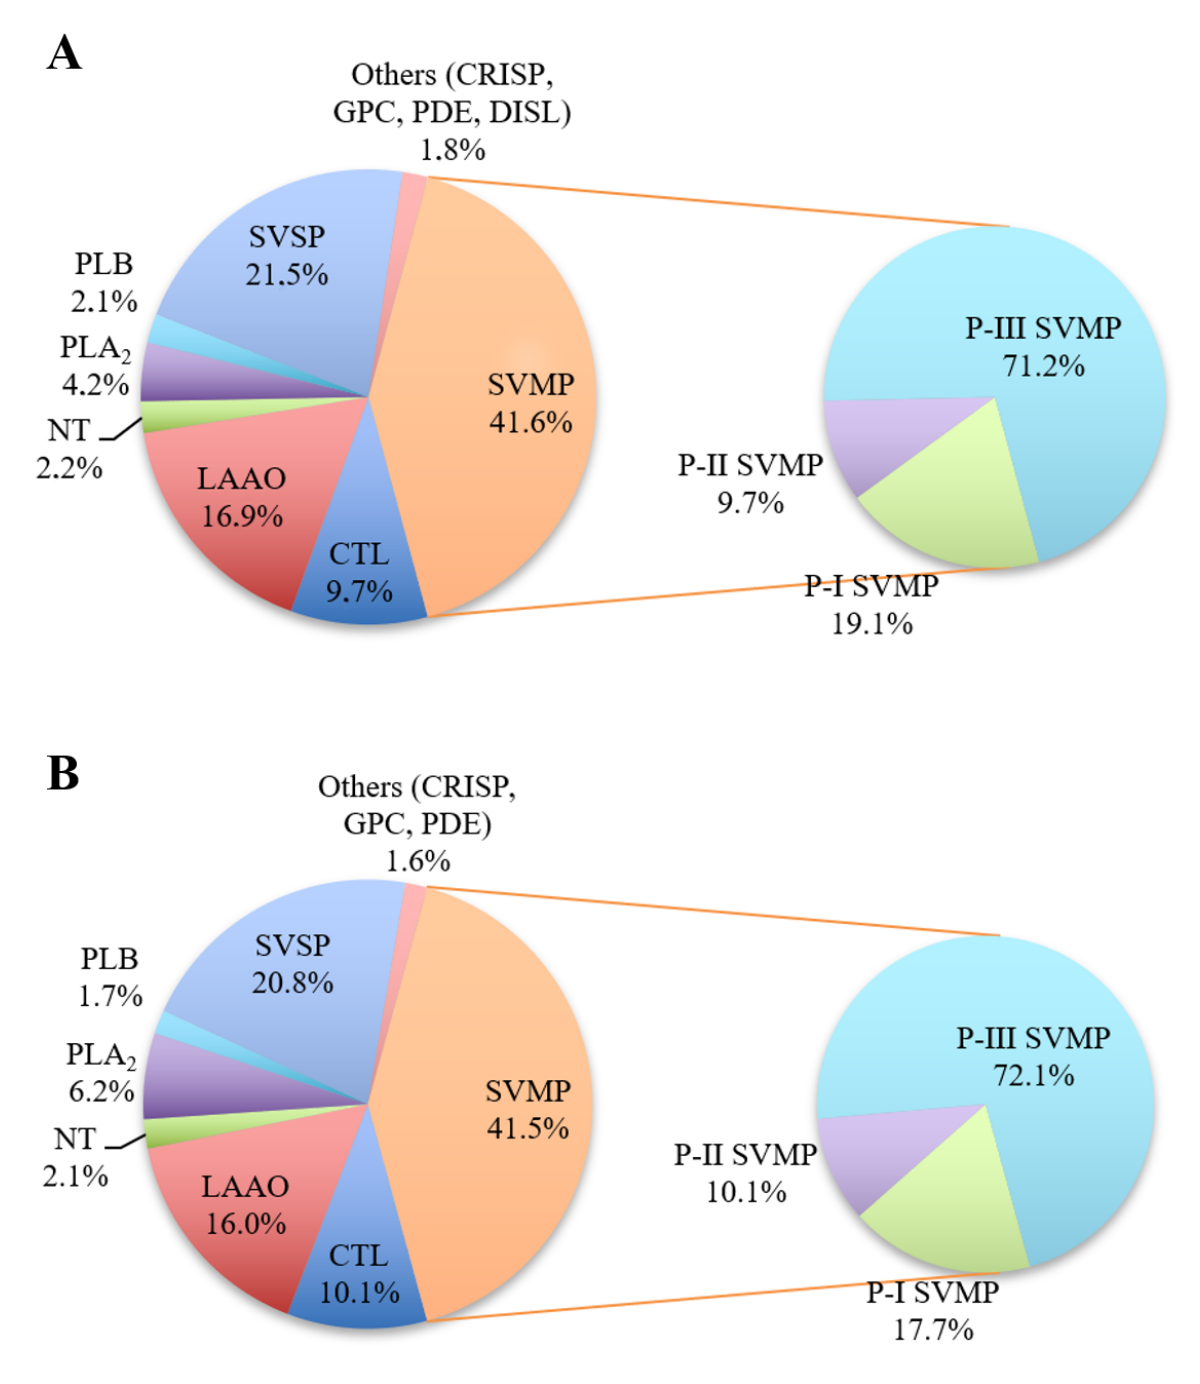
Figure 2. Graphical overview of toxin classes identified in B. atrox (A) female and (B) male venom pools by in nanoESI-qTOF. CRISP: cystein-rich secretory protein; CTL: C-type lectin; DISL: disintegrin-like protein; GPC: glutaminyl-peptide cyclotransferases; LAAO: L-amino acid oxidase; NGF: nerve growth